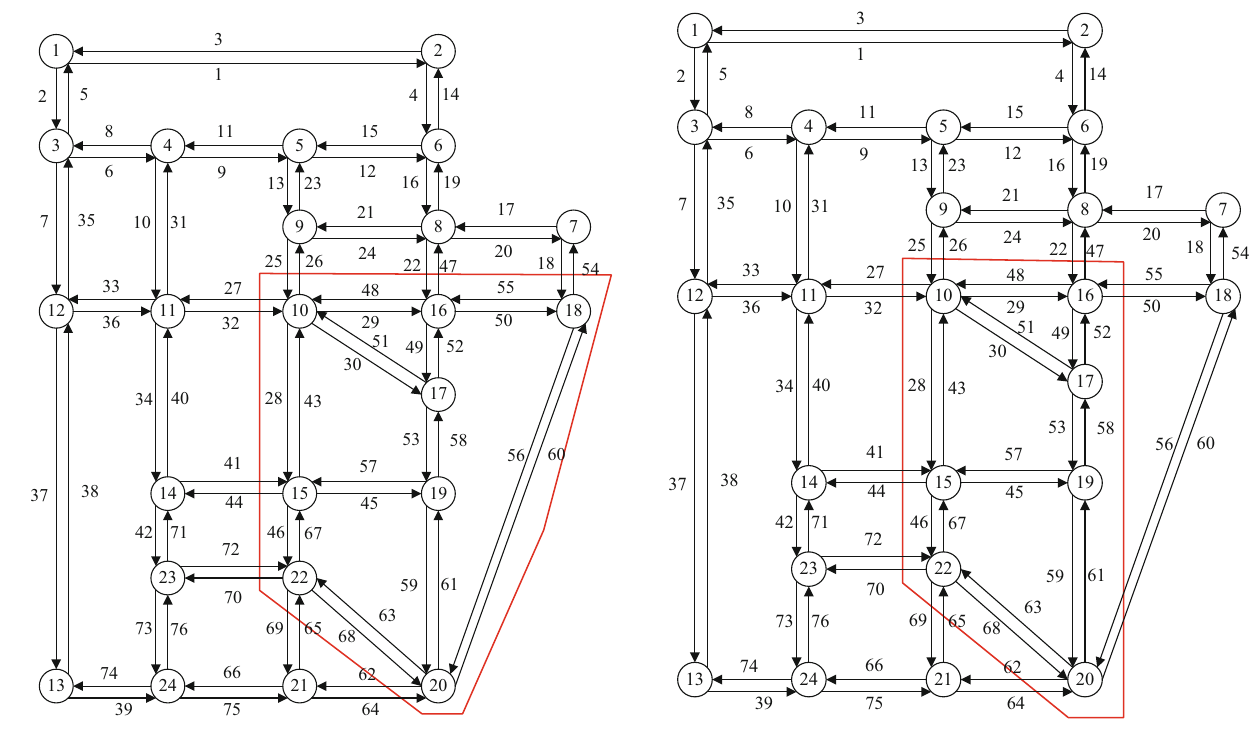
Fig. 11 Impact area identification based on the link flow sources and composition before closing link